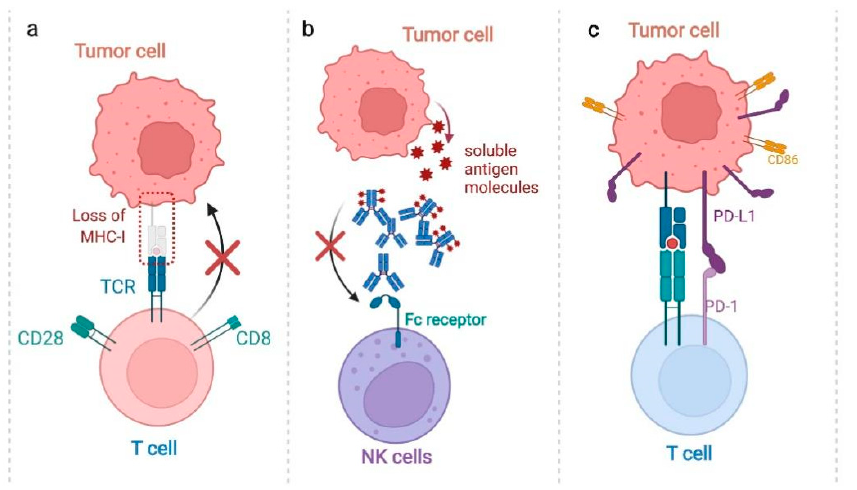
Figure 1. The mechanisms underlying tumor immune escape. ( a ) Low immunogenicity: Cancer cells can escape immune surveillance through downregulating the tumor-specific antigen. Cancer cells with strong immunogenicity induce effective antitumor immune responses and are easily eliminated, while cells with negative antigen and downregulated MHC-I/II expression can escape from the immune system. ( b ) Inhibited ADCC: Cancer cells could also release antigen molecules, which form complexes with antitumor antibodies. Free antibodies could bind to Fc receptors through the Fc segment of the antibody, and then mediate antibody-dependent cellular cytotoxicity (ADCC). However, the depletion of antitumor antibodies by soluble antigen molecules and the blocking of Fc receptors inhibits ADCC and promote tumor immune escape. ( c ) Overexpressed immune checkpoint: Cancer cells are capable of escaping from the immune surveillance by overexpressing B7 family molecules (such as CD86 or PD-L1), which suppress antitumor T-cell responses by binding to the PD-1 receptor.